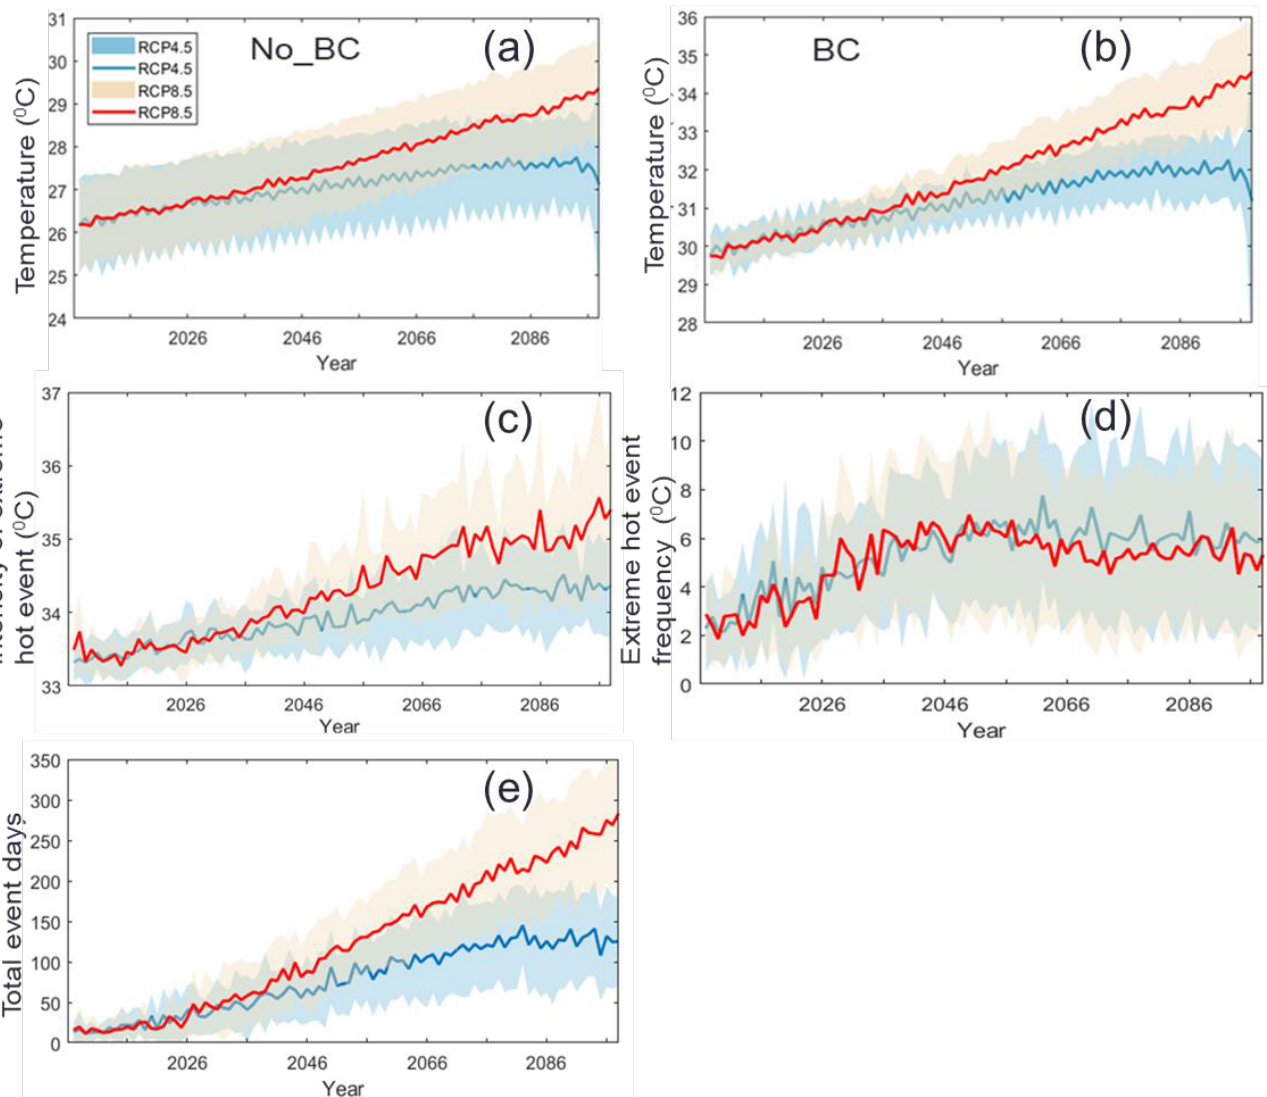
Figure 4. Daily maximum temperature and extreme heat event metric projections for SJMA. Top row ( a , b ) shows bias-corrected and uncorrected projections of daily maximum temperature; mid-row ( c ) shows mean heat wave intensity (bias-corrected) and mean heat wave frequency ( d ) (bias-corrected). Bottom row ( e ) shows the total extreme hot days per year. Solid blue and red bands indicate the 25-model ensemble mean, with shaded bands representing bootstrapped 95% confidence intervals.